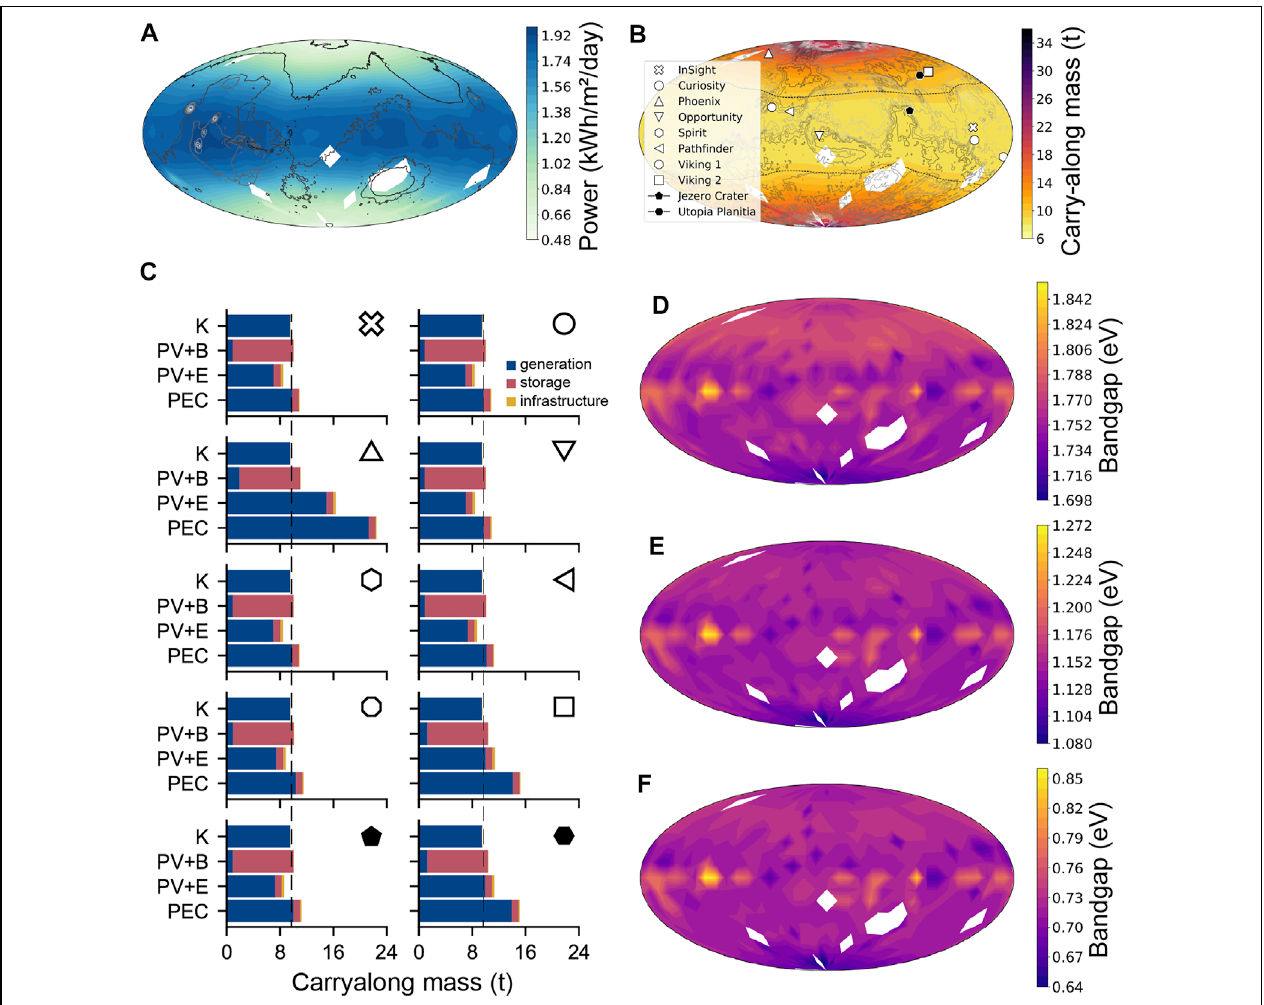
FIGURE 4 | Solar productivity across the Martian surface. (A) Average daily solar power production capacity across the Martian surface. (B) Total carry-along mass required for power production using the PV + E generation system. Black dashed line corresponds to breakeven location with nuclear power generation. (C) Carry-along mass breakdown for locations in (B) for each power generation option. Black dashed line corresponds to breakeven with nuclear power generation. Optimal (D) top, (E) middle, (F) bottom bandgaps for the 3-junction PV